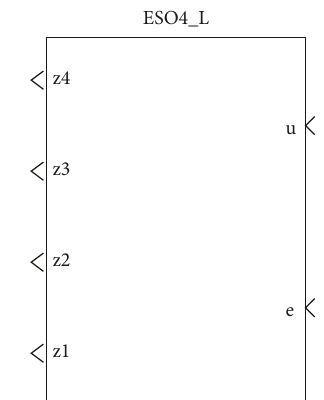
Figure 15: Packaged ESO4_L subsystem